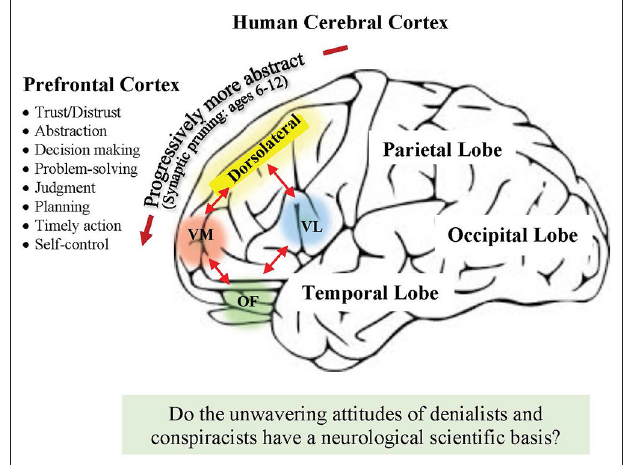
FIGURE 1 | Schematic of the human brain and prefrontal cortex (PFC) which constitutes more than 25% of the entire cerebral cortex. The PFC is where executive functions are carried out and depend on working memory, flexible thinking, and self-control (61). Accepting, doubting or distrusting ideas are believed to occur largely in the dorsolateral region, which communicates with the ventromedial (VM), ventrolateral (VL) and orbitofrontal (OF), and other parts of the brain, which all play a role in controlling our personal beliefs and behavior (61, 62). The development of abstract thinking is believed to occur during childhood from the age of six and involves the anteriorization of circuitry and synaptic pruning (63–65). This early anteriorization may provide a new window of opportunity for teaching how to distinguish truth from falsehood in our educational systems (see